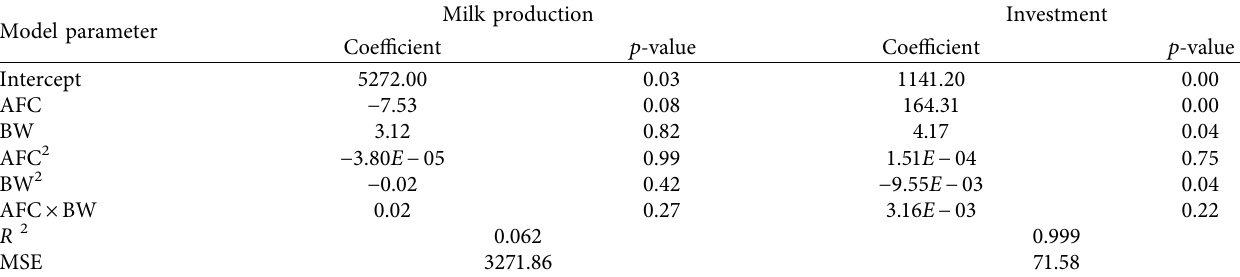
Table 4: Second-order model coefcients for predicting milk production and investment.